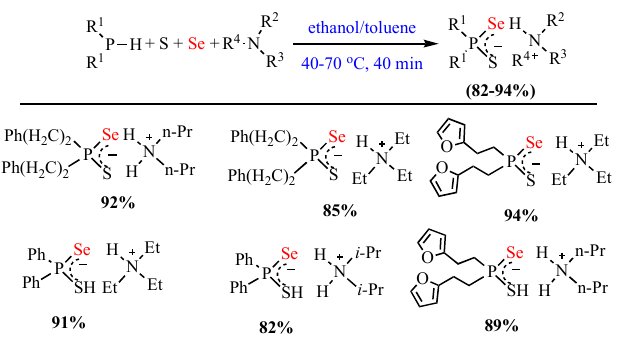
Scheme 14. Synthesis of diselenophosphinates.